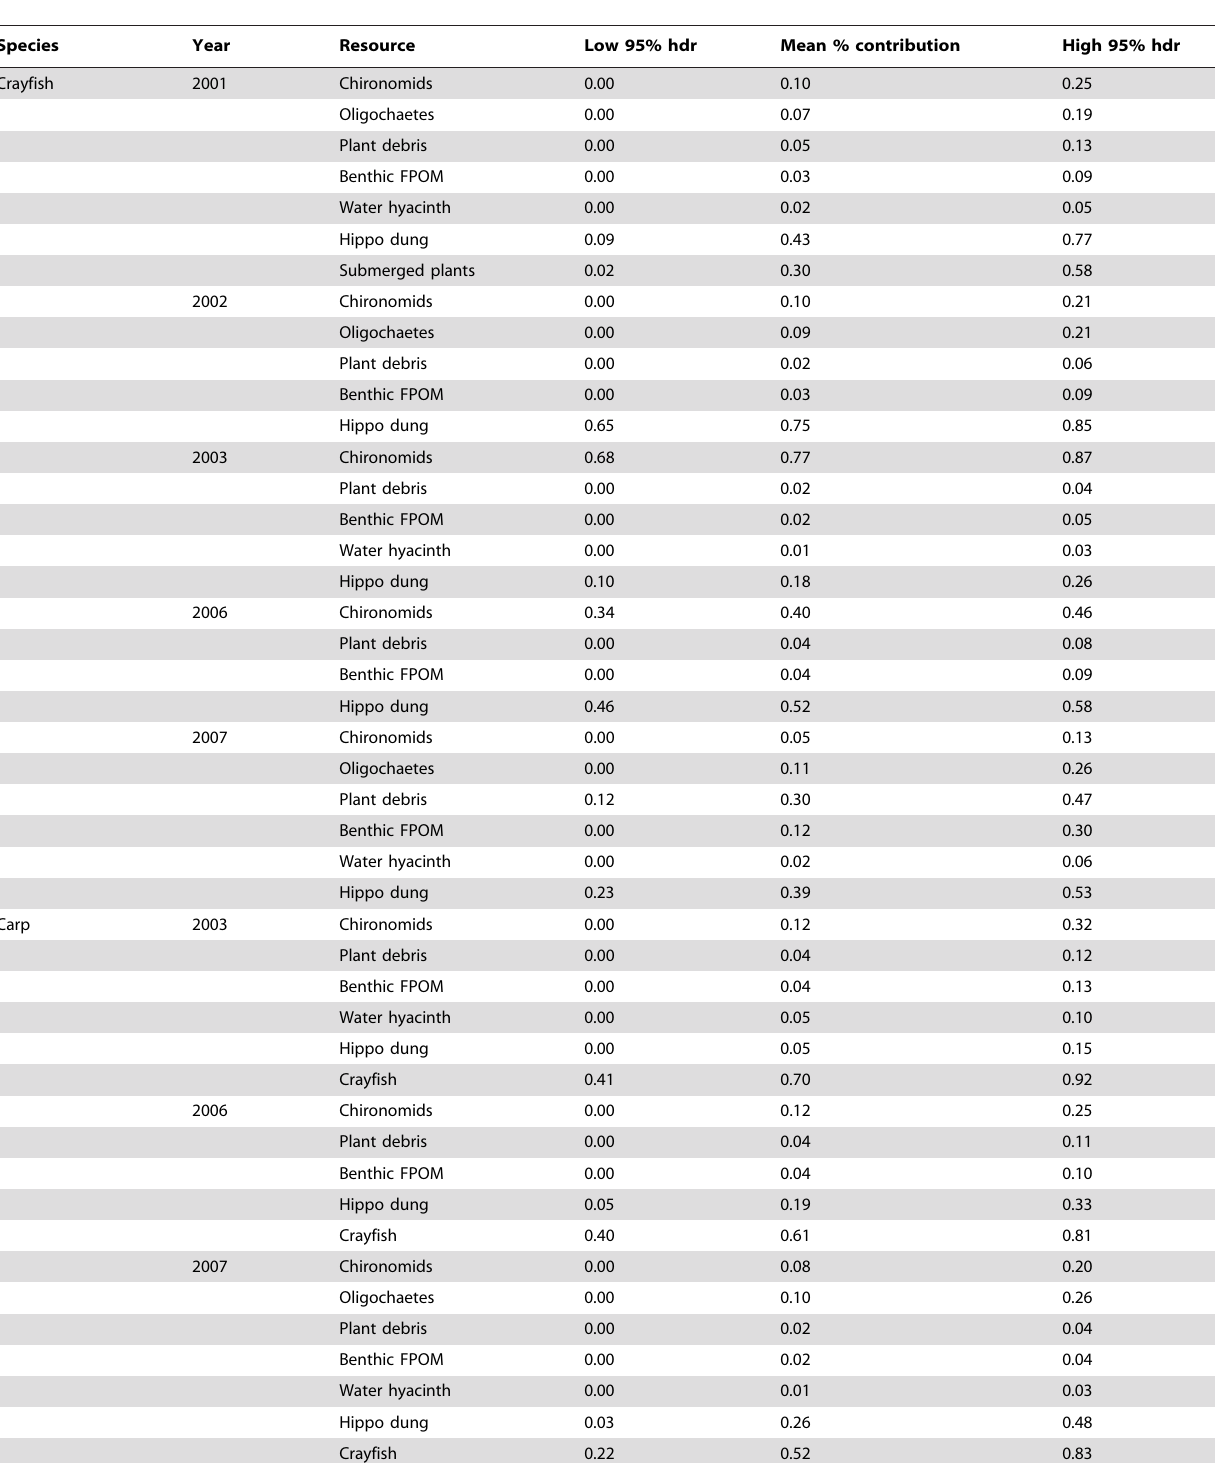
Table 2. The relative contribution of putative resources to the diet of crayfish and carp from 2001 to 2007.